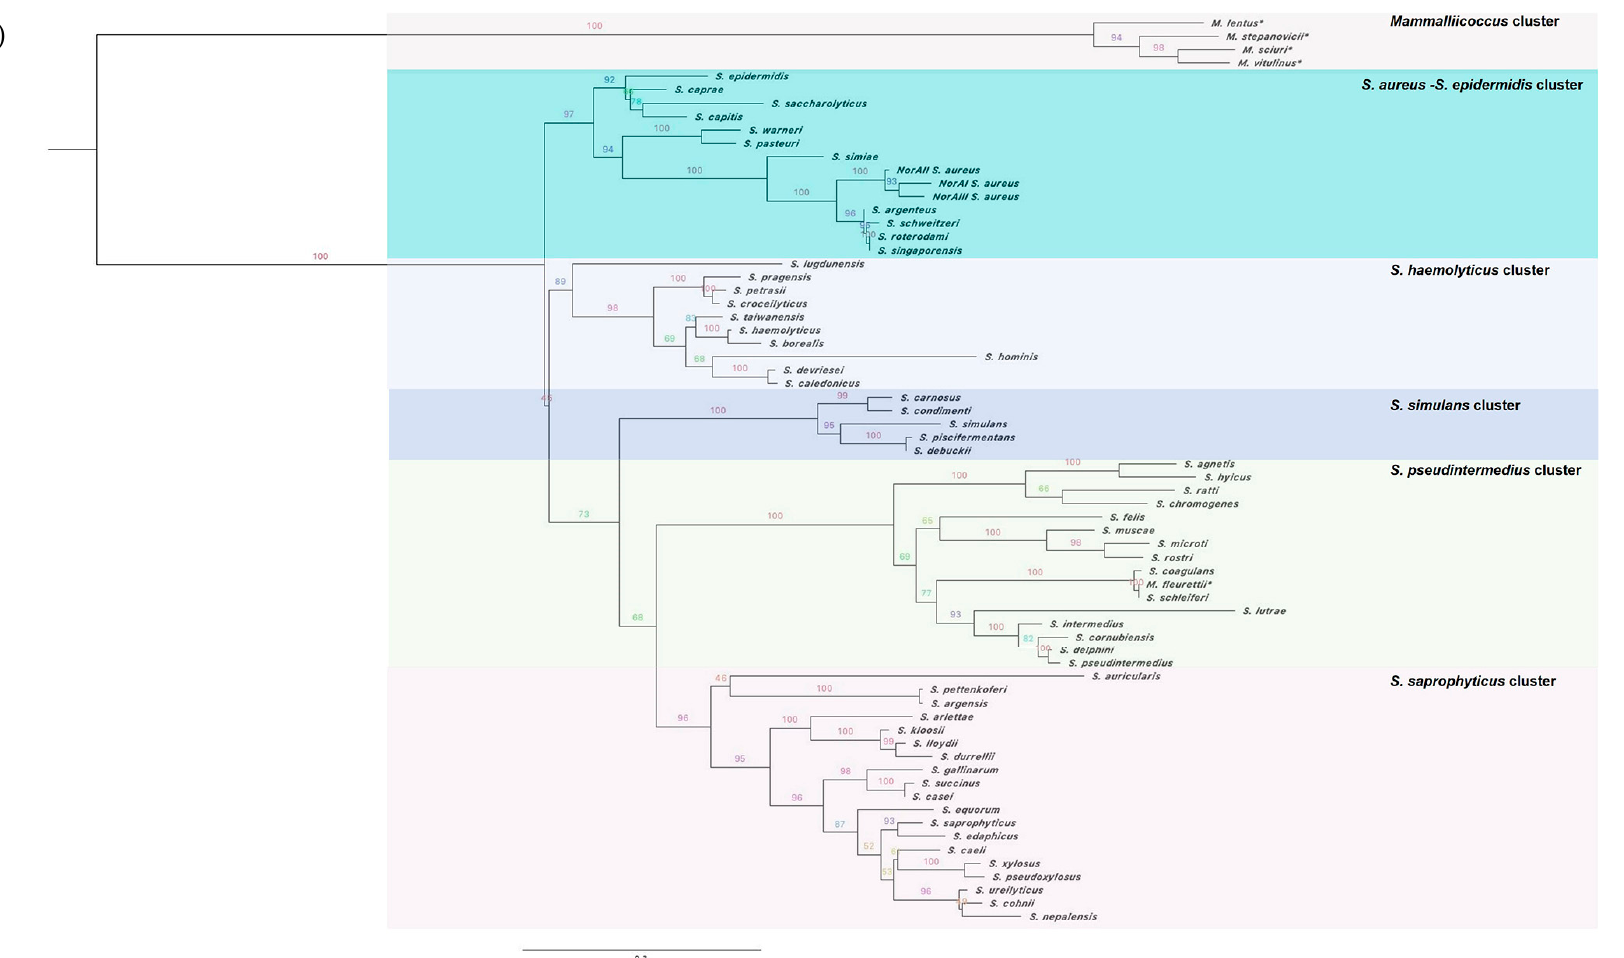
Figure 1. Phylogenetic analysis of the norA efflux pump gene ( A ) and NorA efflux pump ( B ) across the Staphylococcus genus. Maximum likelihood (ML) consensus tree rooted at midpoint and drawn to scale, with branch lengths in the scale of nucleotide ( A ) or aminoacid ( B ) substitutions per site. Bootstrap support values are illustrated at branch nodes. The species highlighted by * correspond to the species that were recently proposed to be reclassified from Staphylococcus to the new Mammalliicoccus